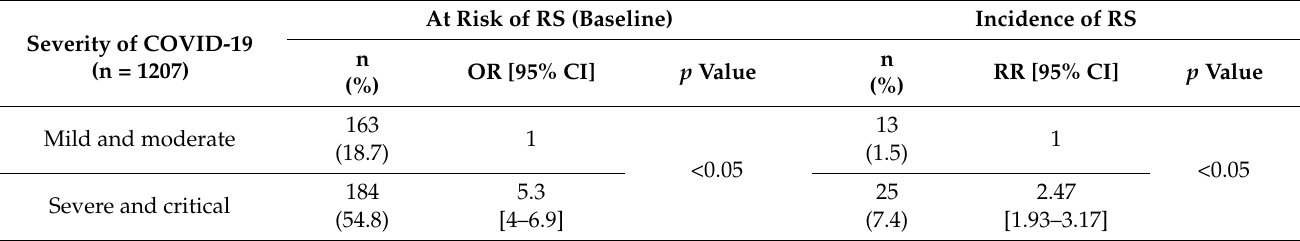
Table 5. The proportion of RS at-risk patients and RS according to severity of COVID-19 and the association between RS and severity of the